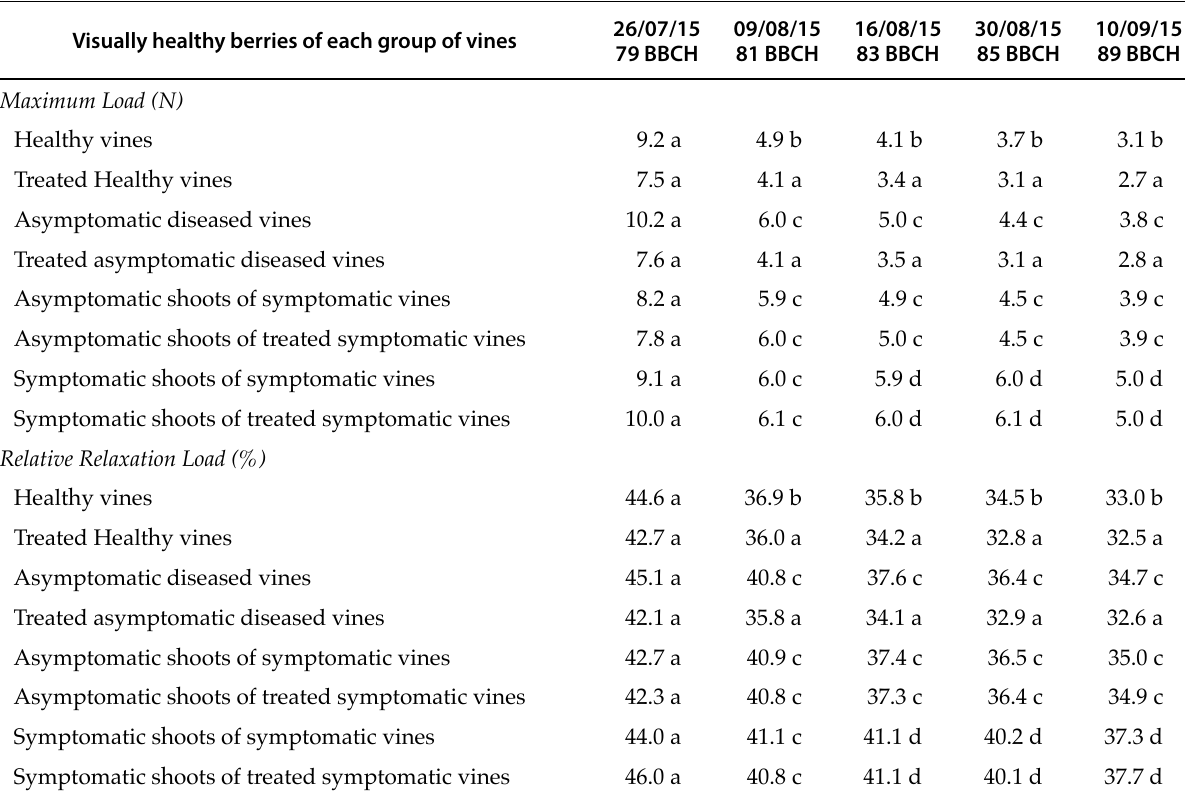
Table 5. Mechanical properties recorded in 2015, and statistical analysis results (HSD at P ≤0.05) for berries of cv. Trebbiano d’Abruzzo treated with the mixture of CaCl 2 , Mg(NO 3 ) 2 , seaweed extract, and in the untreated control. HSD = Tukey’s honest significant difference